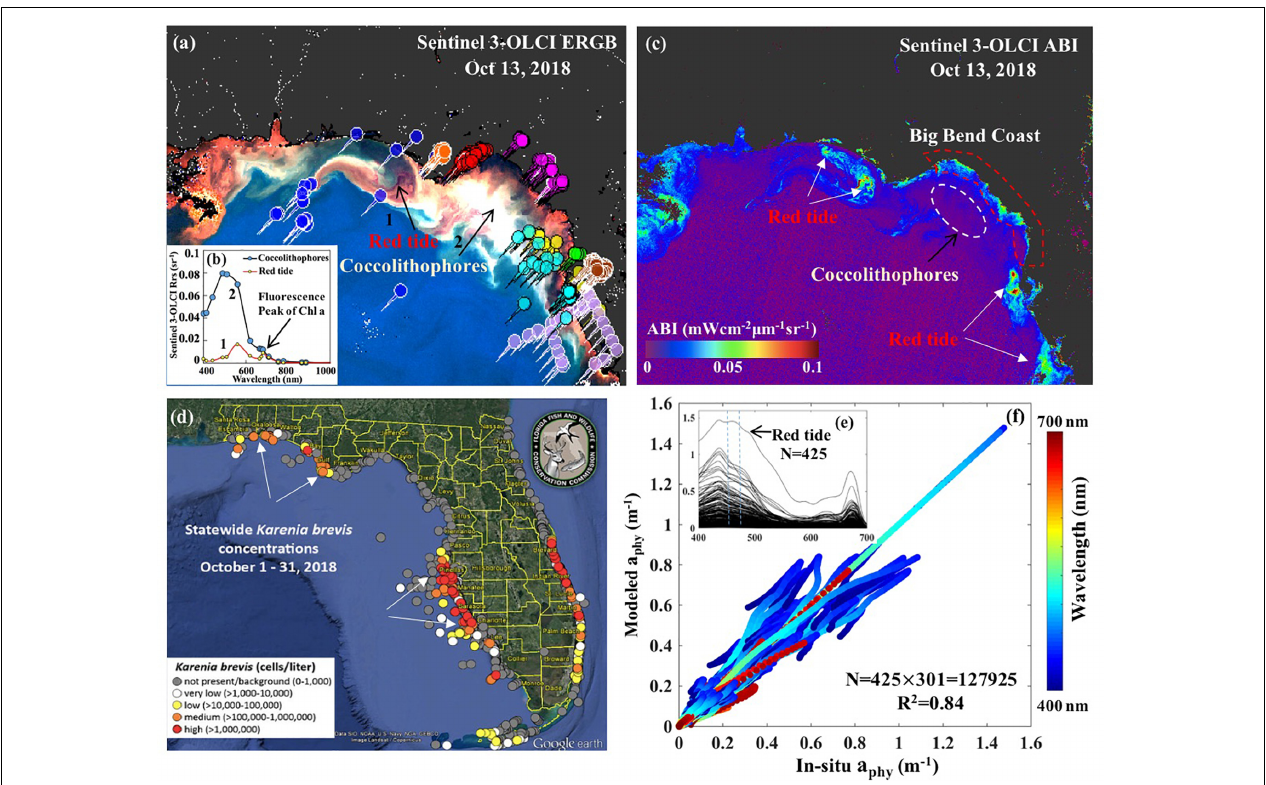
FIGURE 10 | Sentinel-3A OLCI imagery and field absorption spectra. (a) OLCI enhanced RGB imagery (ERGB) of 13 Oct 2018 with arrows indicating dark features associated with high absorption due to red tide and bright features related to coccolithophore bloom. ( b -inset) OLCI-derived R rs spectra corresponding to red tide and coccolithophore bloom locations in the imagery. (c) OLCI algal bloom index (ABI) of 13 Oct 2018 with white arrows indicating waters in bloom status. (d) Statewide map of archived status of red tide Karenia brevis in October, 2018 acquired from Florida Fish and Wildlife Conservation Commission (FWC) with colors circles representing the cell concentrations of K. brevis . (e) 425 a phy ( λ ) spectra acquired from NASA SeaBASS archive with locations shown as colored pins in (a) ; blue dotted lines drawn to show spectra in the range 450–470 nm. (f) Comparison between modeled and in-situ measured a phy ( λ ) for all data across all wavelength with color representing